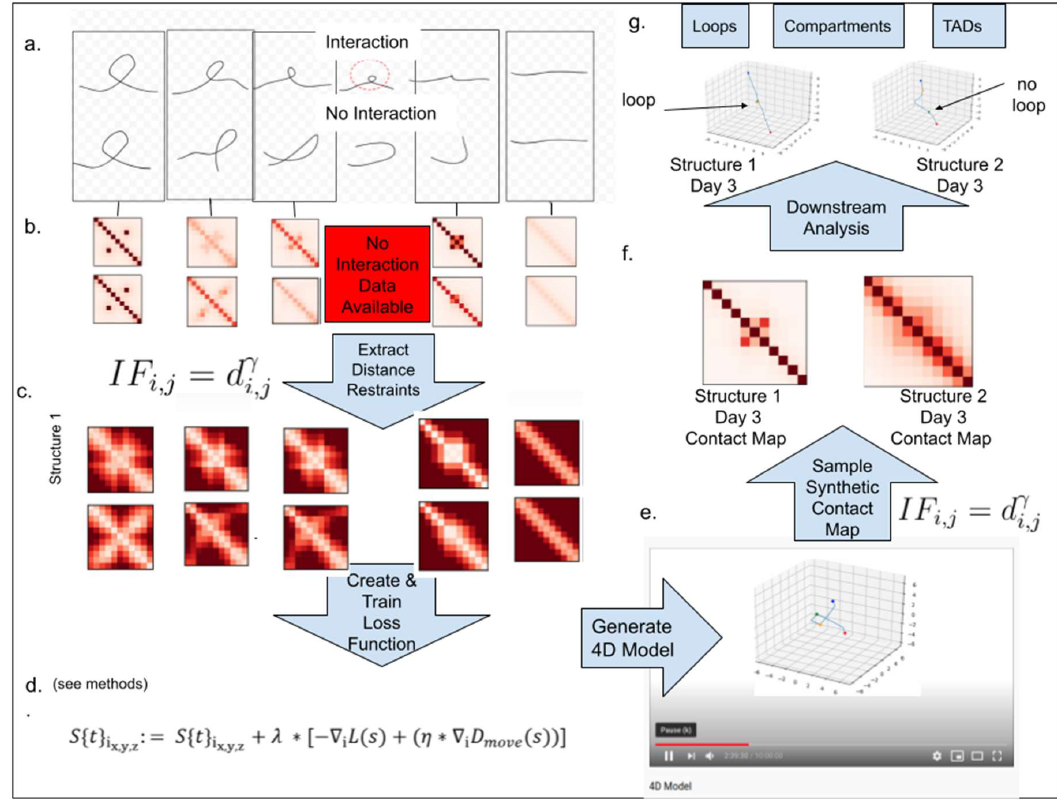
Figure 1. The graphic elucidates the 4DMax workflow using a simplified synthetic dataset as illustration. ( a ) Drawings of two potential chromosomal trajectories from identical starting and ending conformations. A significant contact at the center exists in structure 1 but not structure 2. ( b ) Contact maps obtained through synthetic Hi-C experiments on each day in the process. ( c ) Distance restraints derived from available contact maps. ( d ) Likelihood function for predicting 4D conformation. ( e ) Video of changing chromosome conformation. ( f ) Synthetic contact maps extracted at time of interest. ( g ) Different 3D structural conformations on day 3.